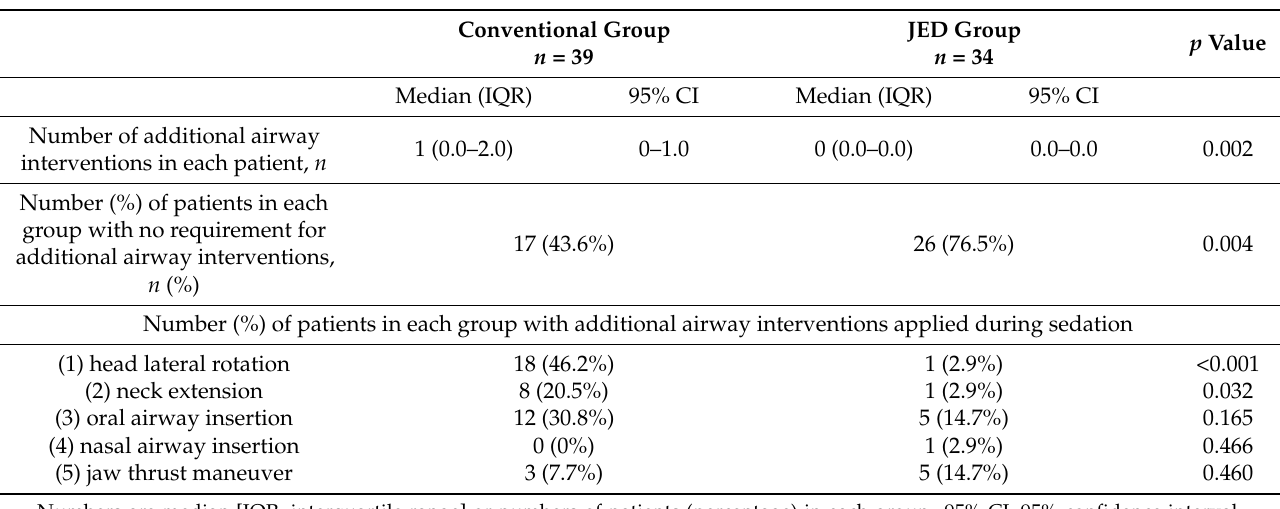
Table 3. Airway interventions during sedation maintenance.